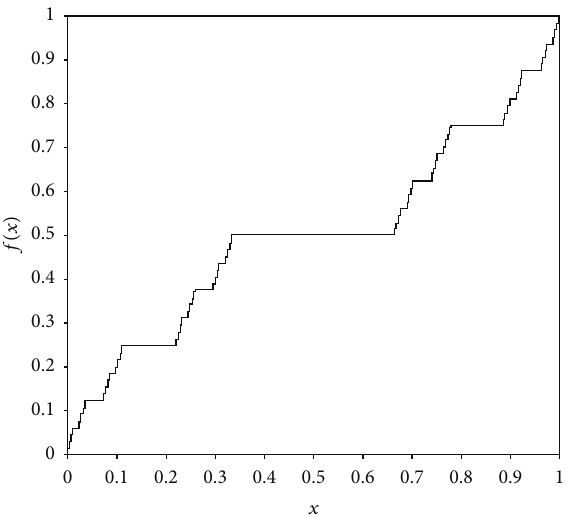
Figure 1: For 𝛼 = ln 2/ ln 3 , graph of a Lebesgue-Cantor staircase function shown at 𝑥 ∈ [0,1]